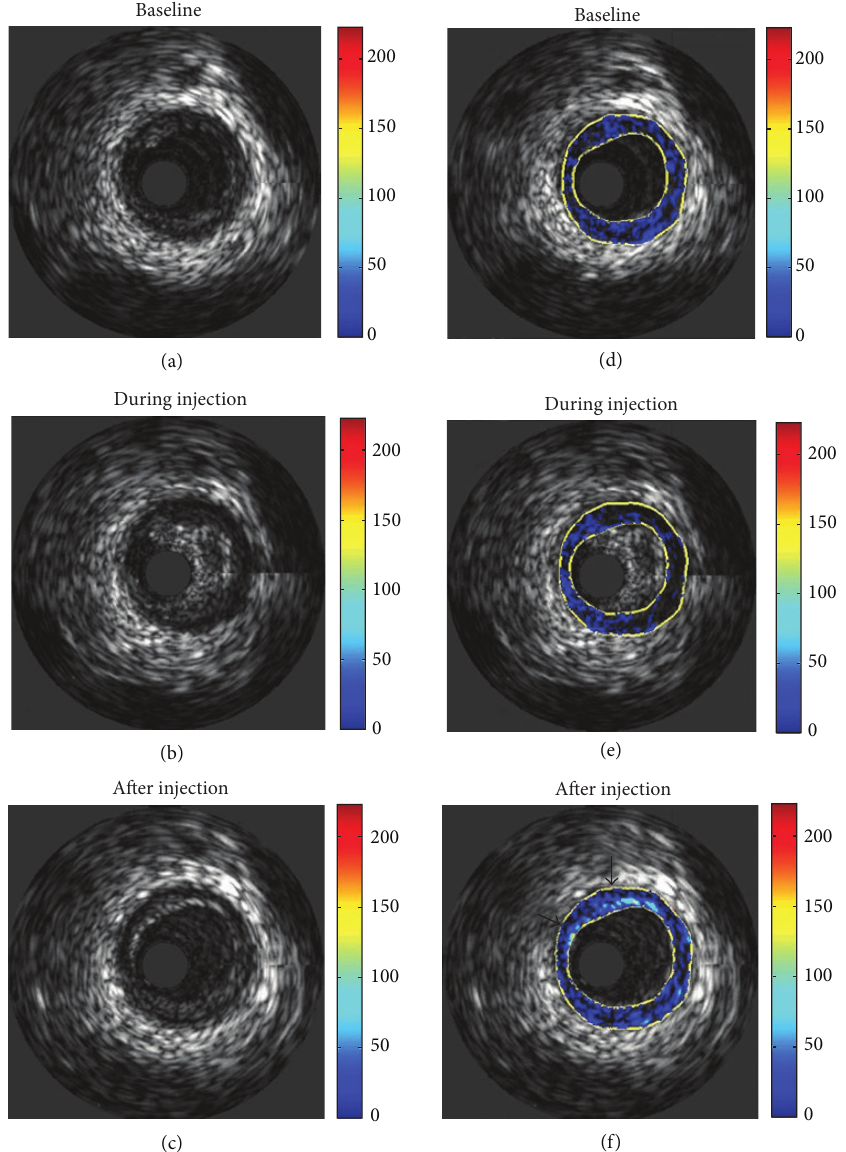
Figure 3: Depiction of qualitative representation of enhancement. Unprocessed images are displayed (a) before, (b) during, and (c) after injection of microbubbles. Corresponding processed images are displayed in (d)–(f). Enhancement is graded from minimal (blue) to maximal (red). Values are a percentage of the maximum grey level intensity difference (255). Arrows indicate points of intense, stable enhancement at the media-adventitia border. Diffuse points of enhancement are present nearby. Reprint with permission from